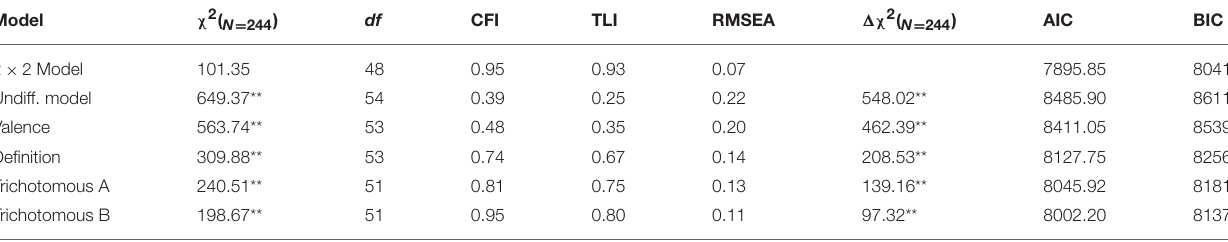
TABLE 2 | Study 1: Comparison of the hypothesized model and alternative models. Model